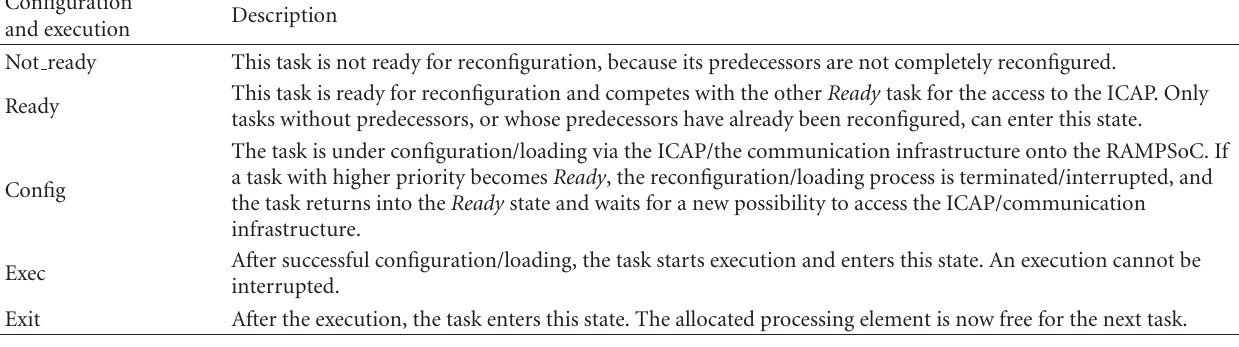
Table 1: Description of the life cycle states of a task.